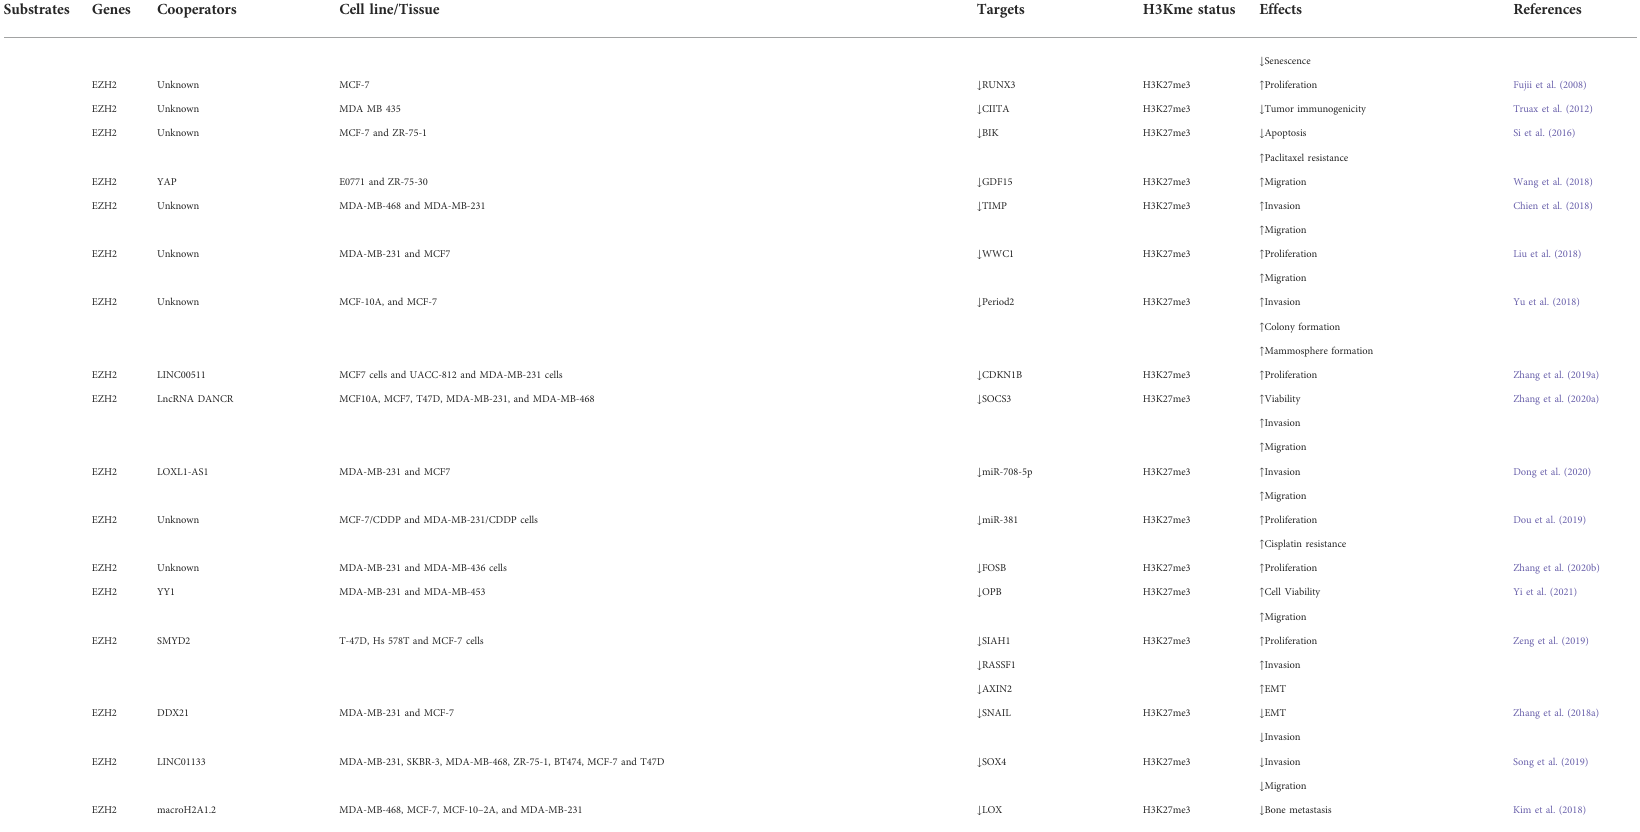
TABLE 1 ( Continued ) Status of histone methylation marks studied in breast cancer